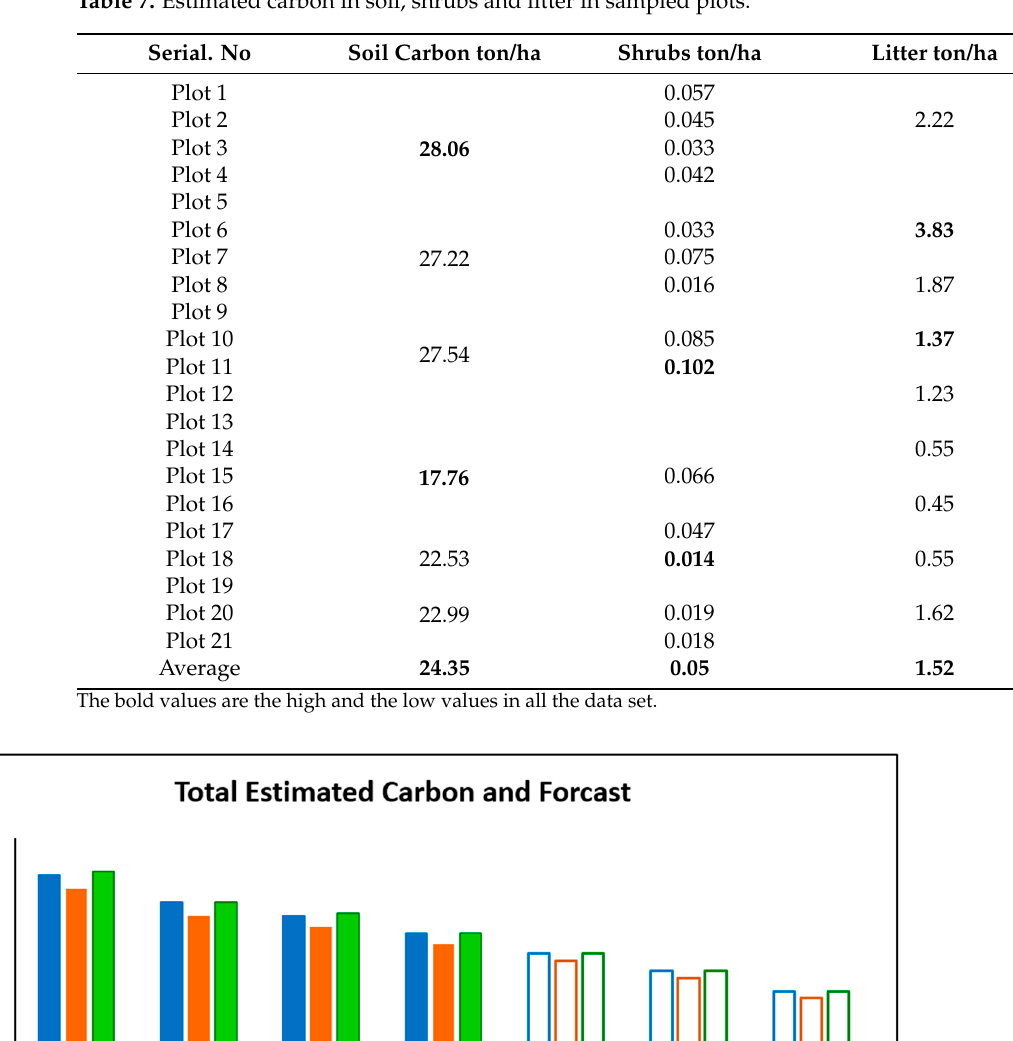
Table 7. Estimated carbon in soil, shrubs and litter in sampled plots.